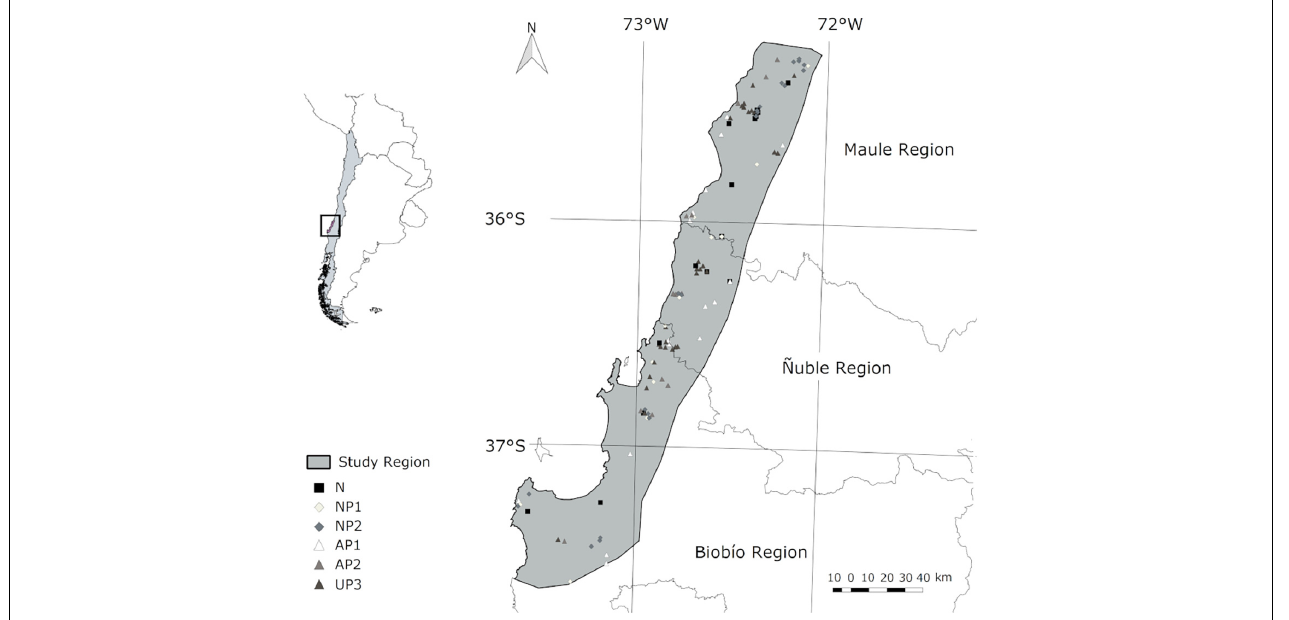
FIGURE 1 | Study region and location of sample units classified as: native forest (N), first rotation pine plantation that replaced native forest (NP1), second rotation pine plantation that replaced native forest (NP2), first rotation pine plantation that replaced agricultural lands (AP1), second rotation pine plantation that replaced agricultural lands and third rotation pine plantation of unknown previous land use (UP3).